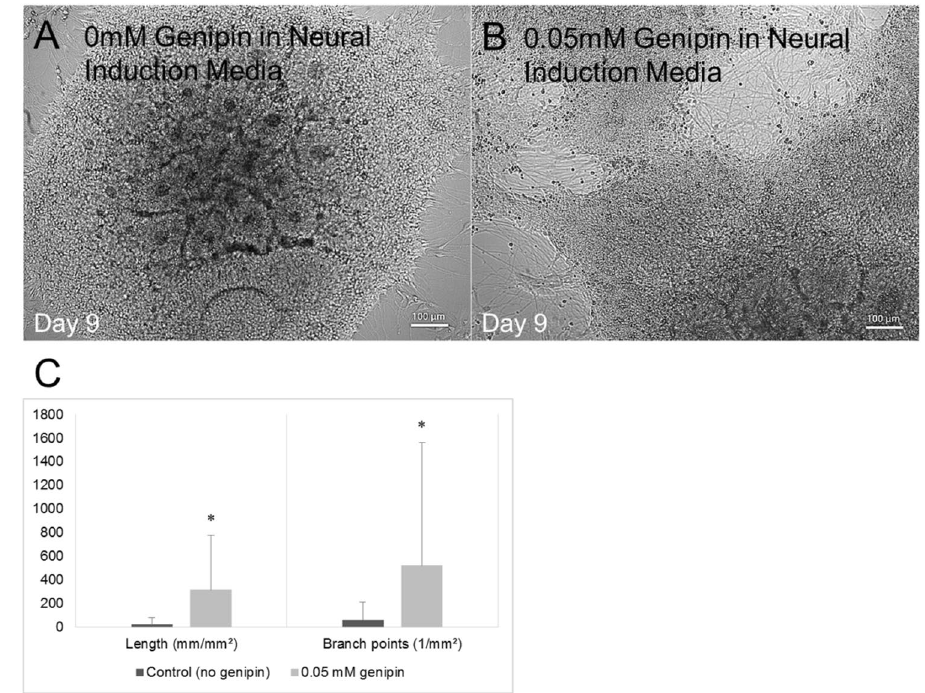
Figure 3. Genipin promotes neurite extension of human iPSC-derived neural progenitors cultured on 2D laminin surfaces. ( A ) Phase contrast image showing an hiPSC-derived neural aggregate with no genipin present. ( B ) Phase constrast image showing an hiPSC-derived neural aggregate treated with 0.05 mM genipin. ( C ) Quantification of the neurite length and branch points for each of the aforementioned groups. The group treated with 0.05 mM genipin showed increased neurite length and increased numbers of branch points, indicating more mature levels of differentiation. * Indicates p < 0.05 compared to control. Each group is represented by its mean average (technical n = 71 measurements) with error bars indicating the standard error of the mean. Each image represents a single neural aggregate with an initial seeding density of 4000 cells/aggregate (biological n =